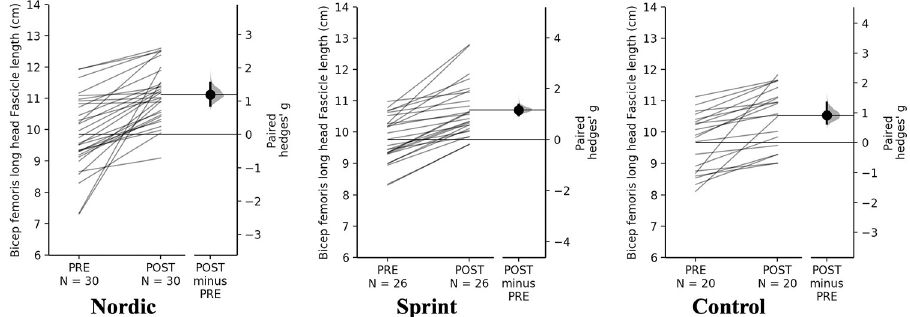
Fig 2. Gardner-Altman estimation plots identifying Pre- and Post-intervention individual changes for absolute bicep femoris fascicle length and Hedge’s g effect size with the 95% CI indicated by the ends of the vertical error